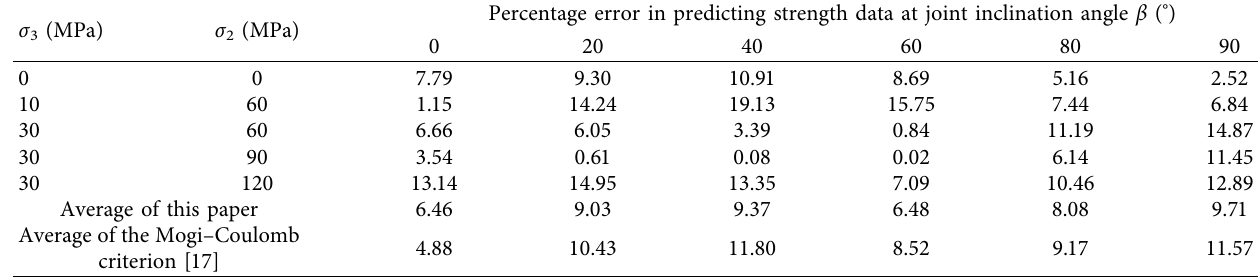
Table 2: Percentage error in predicting strength data of jointed marble.